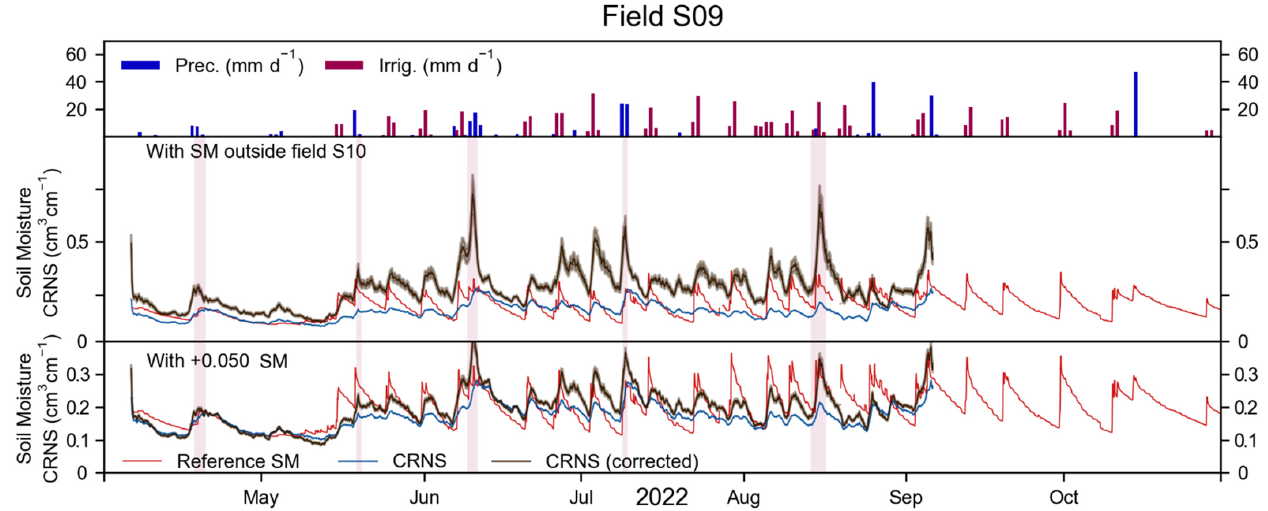
Figure A4 . In the first panel, precipitation for field S10 and irrigation for field S09 during the 2022 irrigation period are shown. In the second panel, reference SM, standard CRNS-derived SM (blue line), and corrected CRNS-derived SM (black line), that used SM values from a sensor outside S10, are shown. In the third panel, results of the CRNS correction, if SM of the sensor outside field S10 is increased by 0.050 cm 3 cm − 3 , are shown.